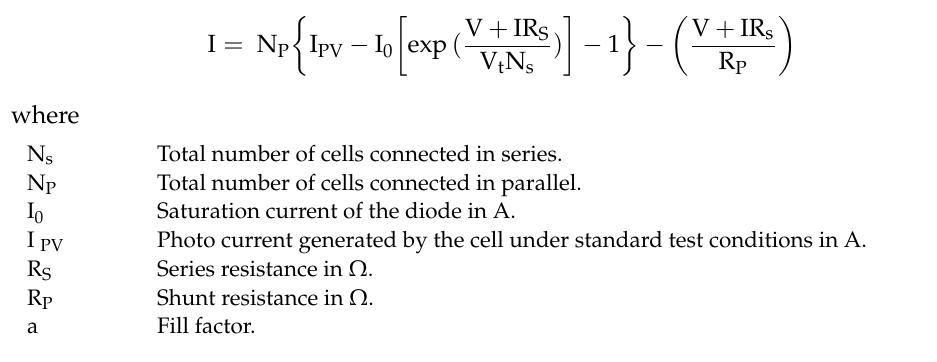
Figure 7. Equivalent circuit of solar cell. The photo current equation of the solar cell is expressed using Equation (11), given by Winston et